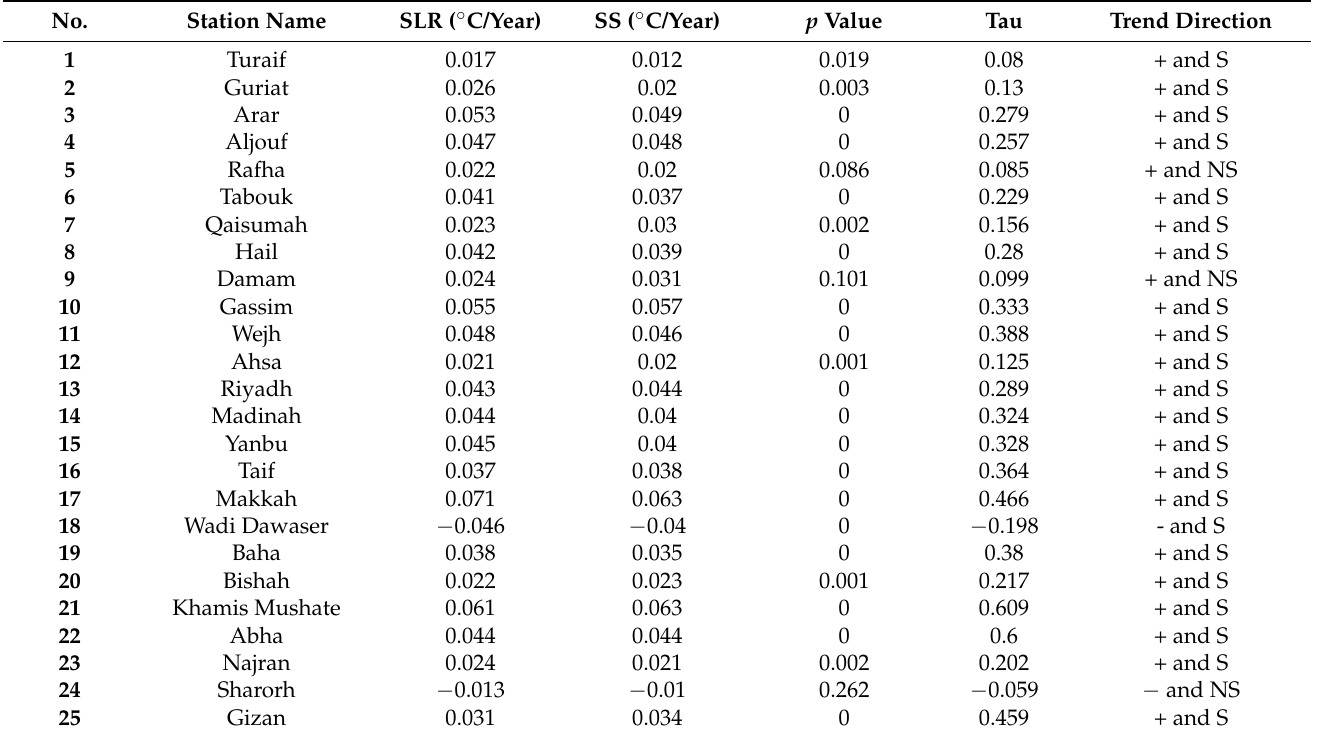
Table 3. Results of trend analysis of Winter Air Temperatures for the 25 stations. The positive sign (+) denotes an increasing trend and the Negative sign ( − ) denotes a decreasing trend. S denotes a significant trend and NS denotes an non-significant